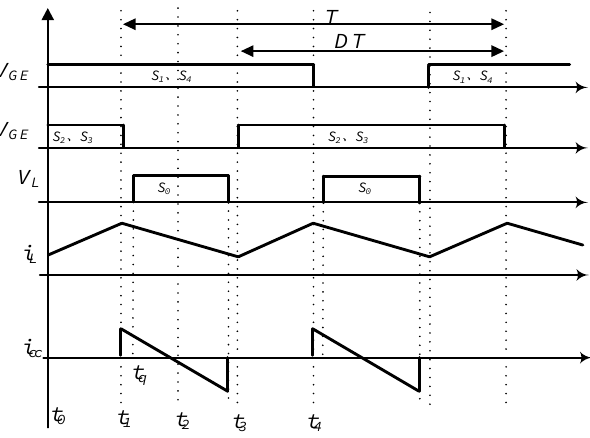
Figure 4. According to the operating characteristics of the boost full bridge isolated topology, the duty cycle of H-bridge power switches meets 0.5 < D < 1. The symmetrical PWM control mode is adopted, that is, the trigger pulse signal of diagonal switches are consistent, and the phase shift between S 1 , S 4 and S 2 , S 3 is 180°. When the power switches S 1 , S 4 or S 2 , S 3 are turned off, the clamping switch S 0 is turned on to share the inductive current and suppress the H-bridge switches turning off voltage spike.